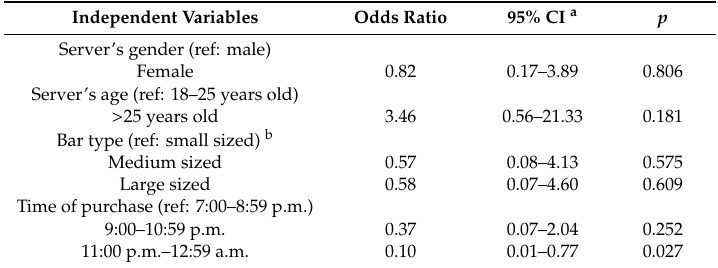
Table 2. Logistic regression analysis of factors influencing